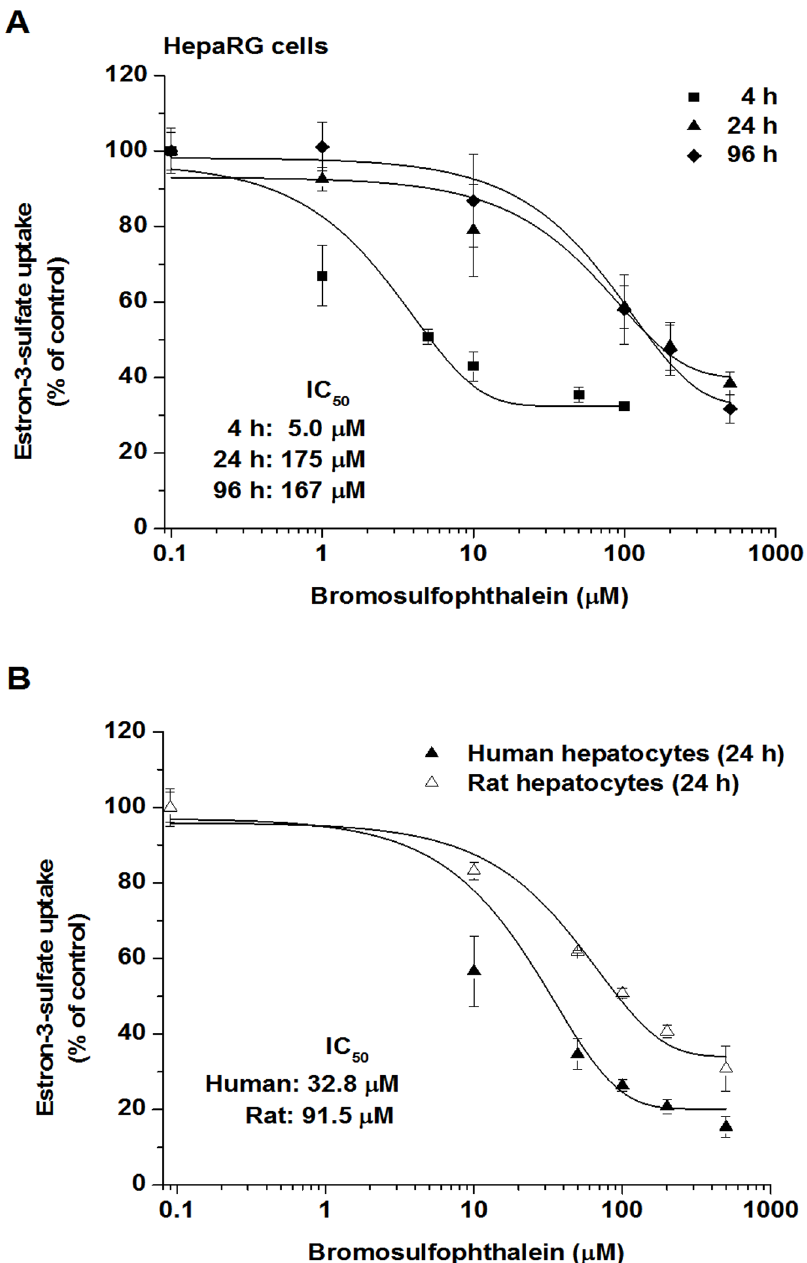
Figure 6. Comparison of the inhibition of E3S uptake by bromosulfophthalein in human and rat hepatocytes and HepaRG cells. (A) HepaRG cells were treated with 1 m M of 3 H-E3S for 120 sec at 4, 24 and 96 h after seeding in the presence of bromosulfophthalein (1–500 m M), or the vehicle. (B) Human and rat hepatocytes were treated with 1 m M of 3 H-E3S for 30 sec at 24 h after seeding in the presence of bromosulfophthalein (1– 500 m M), or the vehicle. Values are expressed as mean 6 SD, assays were run using four wells as one set. All experiments were carried out with hepatocytes from three independent preparations.